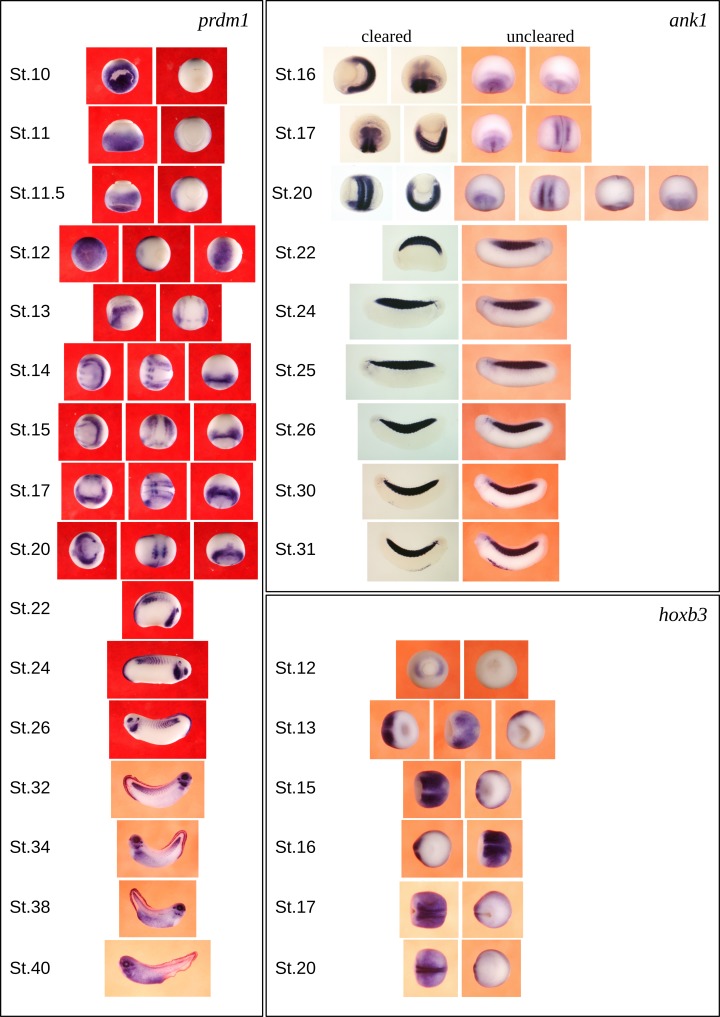
Developmental progression of expression for selected genes prdm1, ank1, and hoxb3 during Xenopus embryo development.This is the result of applying our suite of image analysis tools to (in this case) the 334 original images for these three genes, and reducing them to a representative set of 65 images, including multiple views of expression patterns from the early spherical stages (pre-Stage 22).